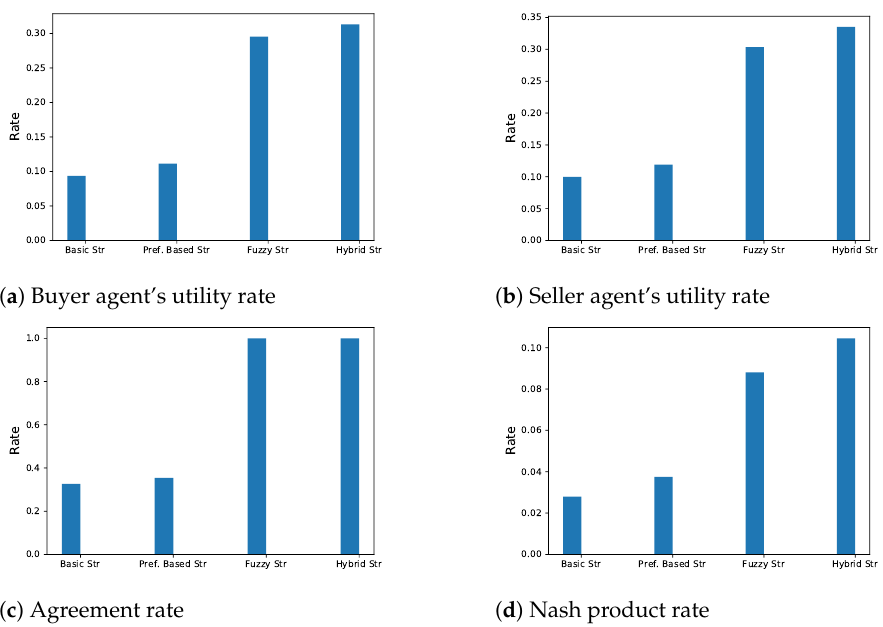
Figure 8. Medium overlap and random deadlines.